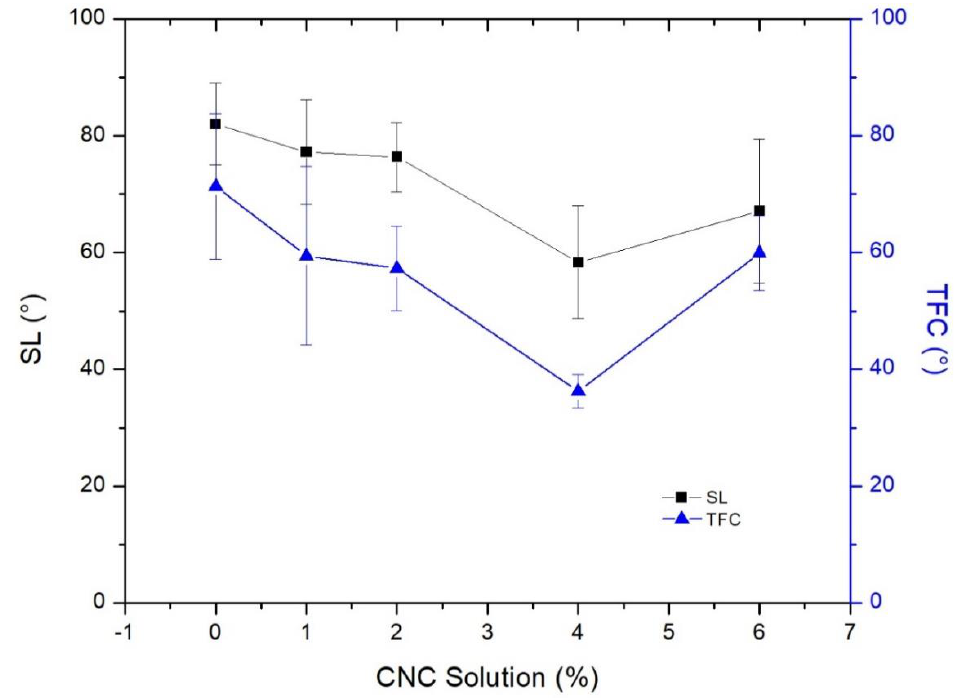
Figure 6. Contact angle for the support layer and thin film composite membrane with different loading ratios of CNCs in the support layer.